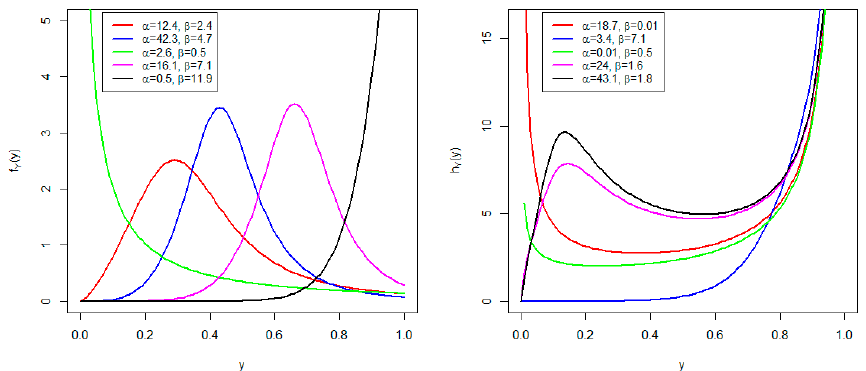
Figure 1. PDF ( left ) and HRF ( right ) plots.